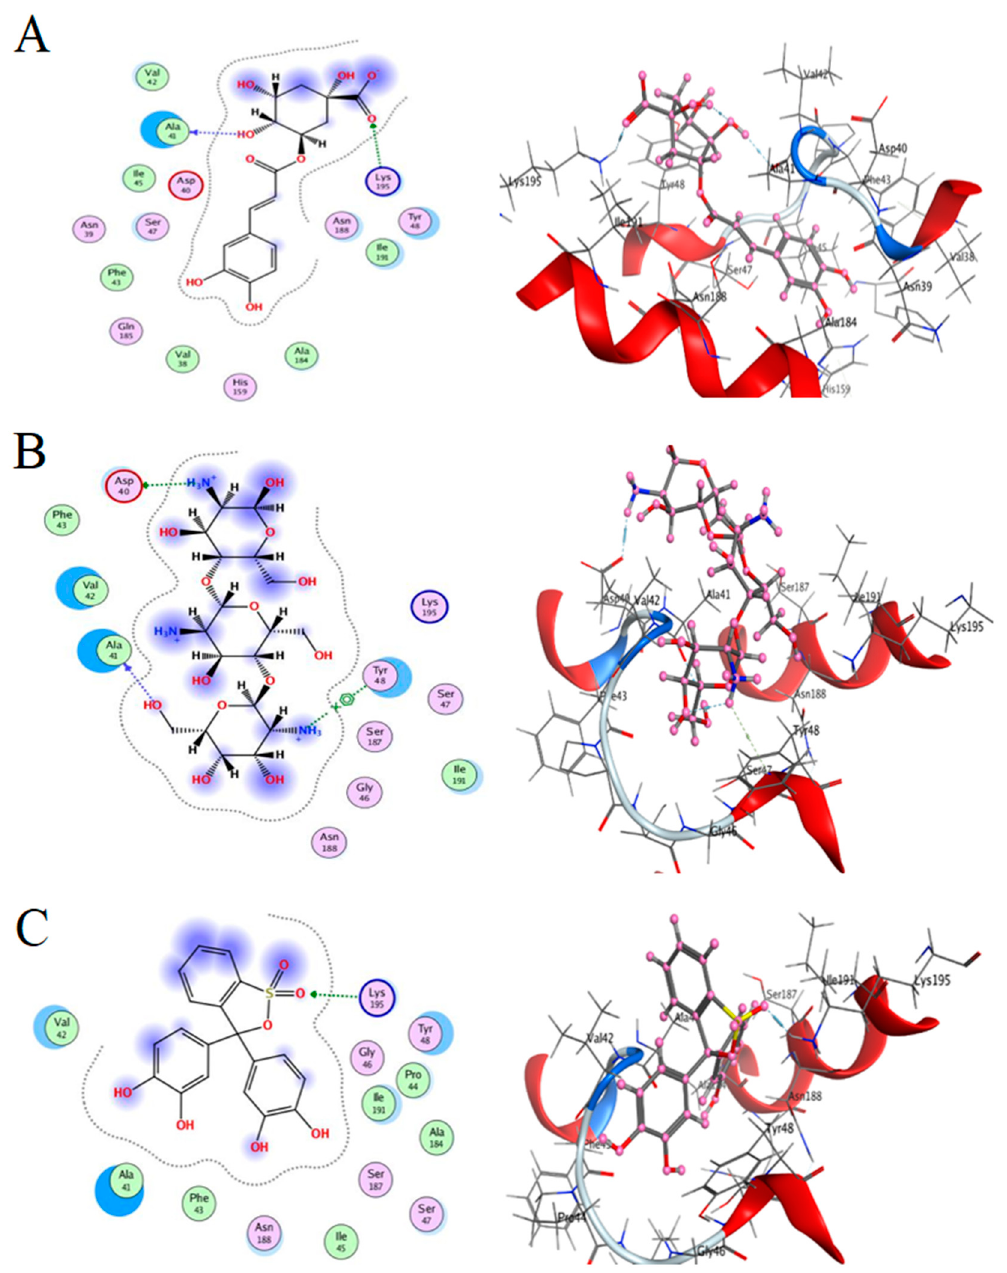
Figure 11. Docking interactions of certain compounds of A. vera gel extract.2D and 3D diagrams show the interaction between chlorogenic acid and active sites of 4HI0 protein ( A ); 2D and 3D di- agrams show the interaction between chitosan and active sites of 4HI0 protein ( B ); 2D and 3D dia- grams show the interaction between pyrocatechol and active sites of 4HI0 protein ( C ). The representative key for the types of interaction between chitosan, chlorogenic acid and pyro- catechol with 4HI0 protein of H. pylori was illustrated in Figure 12.